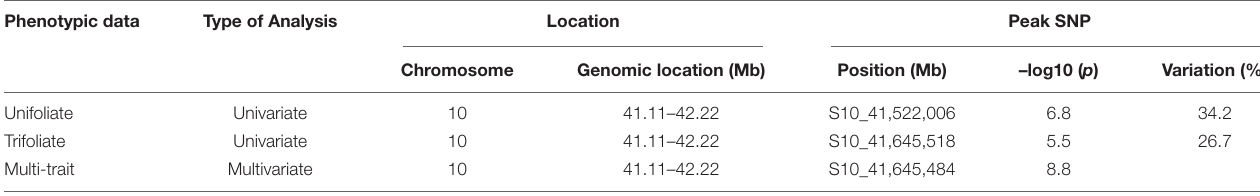
TABLE 5 | GEMMA GWAS results for phenotypic traits in the Andean breeding population. Phenotypic data